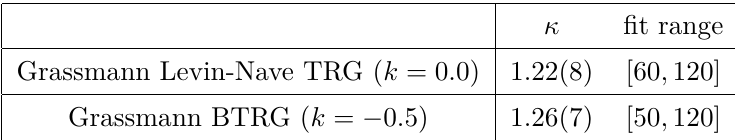
Table 1 . Fit result of the exponent κ